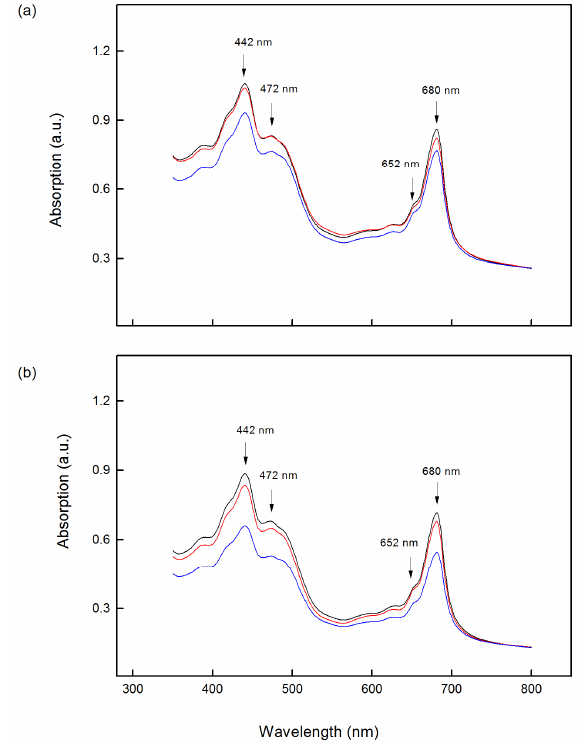
Figure 3. Absorption spectra of thylakoid membranes isolated from the leaves of Paulownia tomen- tosa x fortunei (TF) ( a ) and Paulownia elongata x elongata (EE) ( b ) treated for 10 days with different concentrations of NaCl; black curve (control), red curve (treatment with 100 mM NaCl) and blue curve (treatment with 150 mM NaCl).